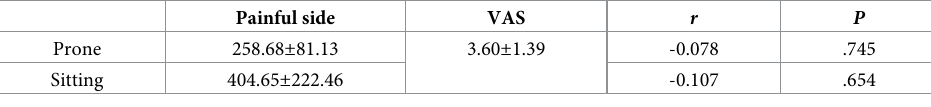
Table 3. Spearman’s rank correlations between VAS and the erector spinae stiffness on painful